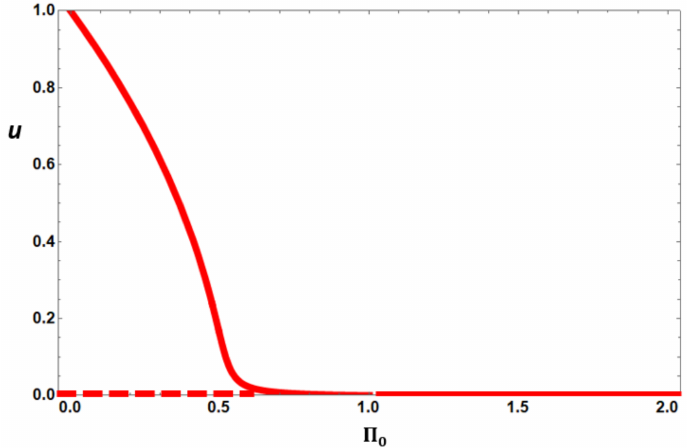
Figure 6. A bifurcation diagram linking steady state criminal activity levels to policing efficiency. The solid line corresponds to a stable steady state and the dashed line to an unstable steady state. In this case, with a = 1.2, b = 0.963 and c = 0.01, the system represents high policing responsiveness to criminal activity. A transcritical bifurcation is